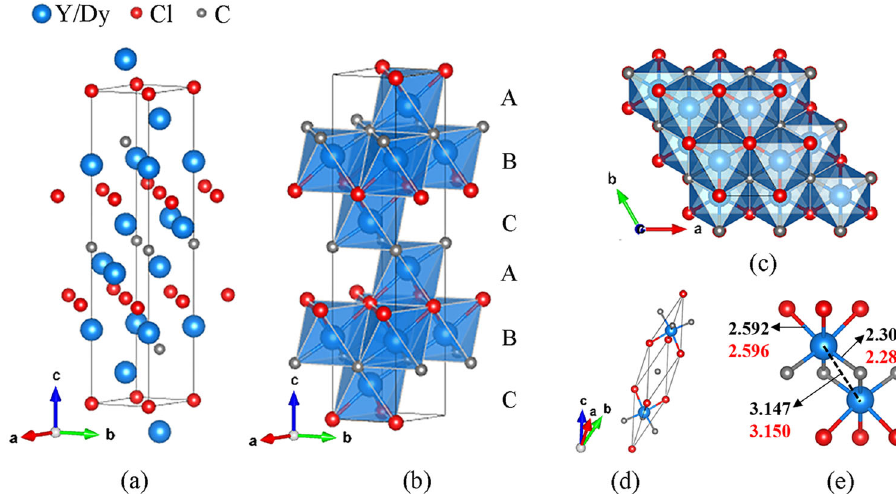
Fig. 3 Crystal structure of Y 2 ClC and Dy 2 ClC synthesized at ~40 GPa. a Ball model in a hexagonal setting. b Polyhedral model built of (YC 3 Cl 3 ) octahedra; A, B, C letters highlight the ccp formed by Y/Dy atoms. c View of the structure along the c -direction; C and Cl atoms together forming the ccp . d Crystal structure in the rhombohedral setting. e Interatomic distances (in Å) in Y 2 ClC (black numbers) and Dy 2 ClC (red numbers). Y/Dy, Cl, and C atoms are shown in blue, red, and gray